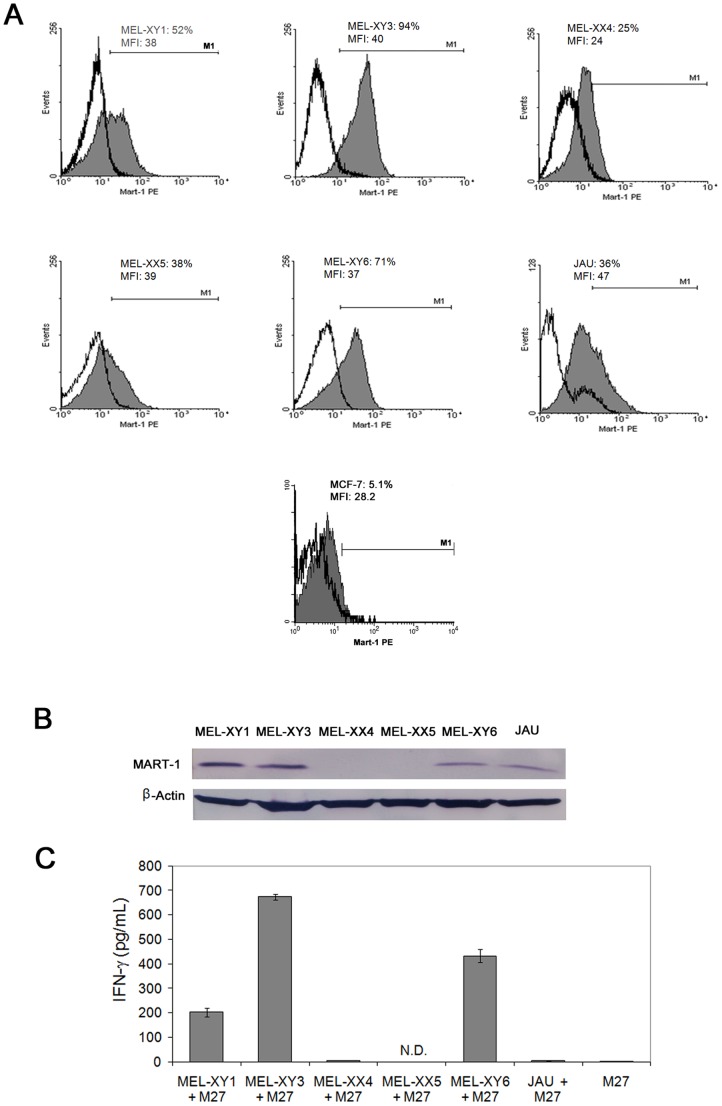
Differential MART-1 expression in melanoma cells and production of
IFN-gamma by M27 CD8+ T cells.(A) Intracellular immunofluorescence was performed with cells from five
melanoma cell lines, in melanoma cells from a primary culture (JAU), and MCF7
breast carcinoma cells. Empty histograms show isotype controls and filled
histograms staining with the 2A9 mAb. Percentage of positive cells and MFI
are indicated. (B) The expression of MART-1 in cells from different melanoma
cell lines was tested by Western blotting with the 2A9 mAb, using an anti-β-actin
mAb as a loading control. (C) IFN-gamma production by MART-1-specific M27
T cell clone. Melanoma cells and M27 cells were co-cultured overnight at a
1∶1 ratio. Culture supernatants were then tested by ELISA for IFN-gamma
content in triplicates. The mean IFN-gamma values (pg/mL ±S.D.) are
indicated. Results are representative of three independent experiments.